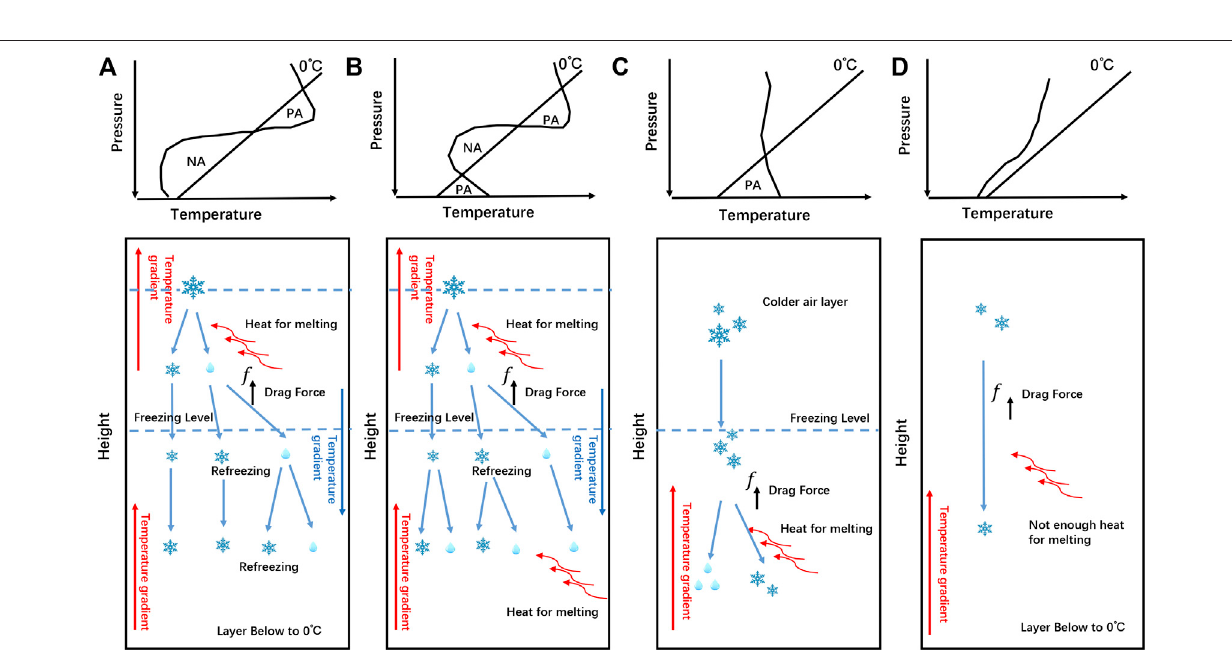
Frontiers in Earth Science |